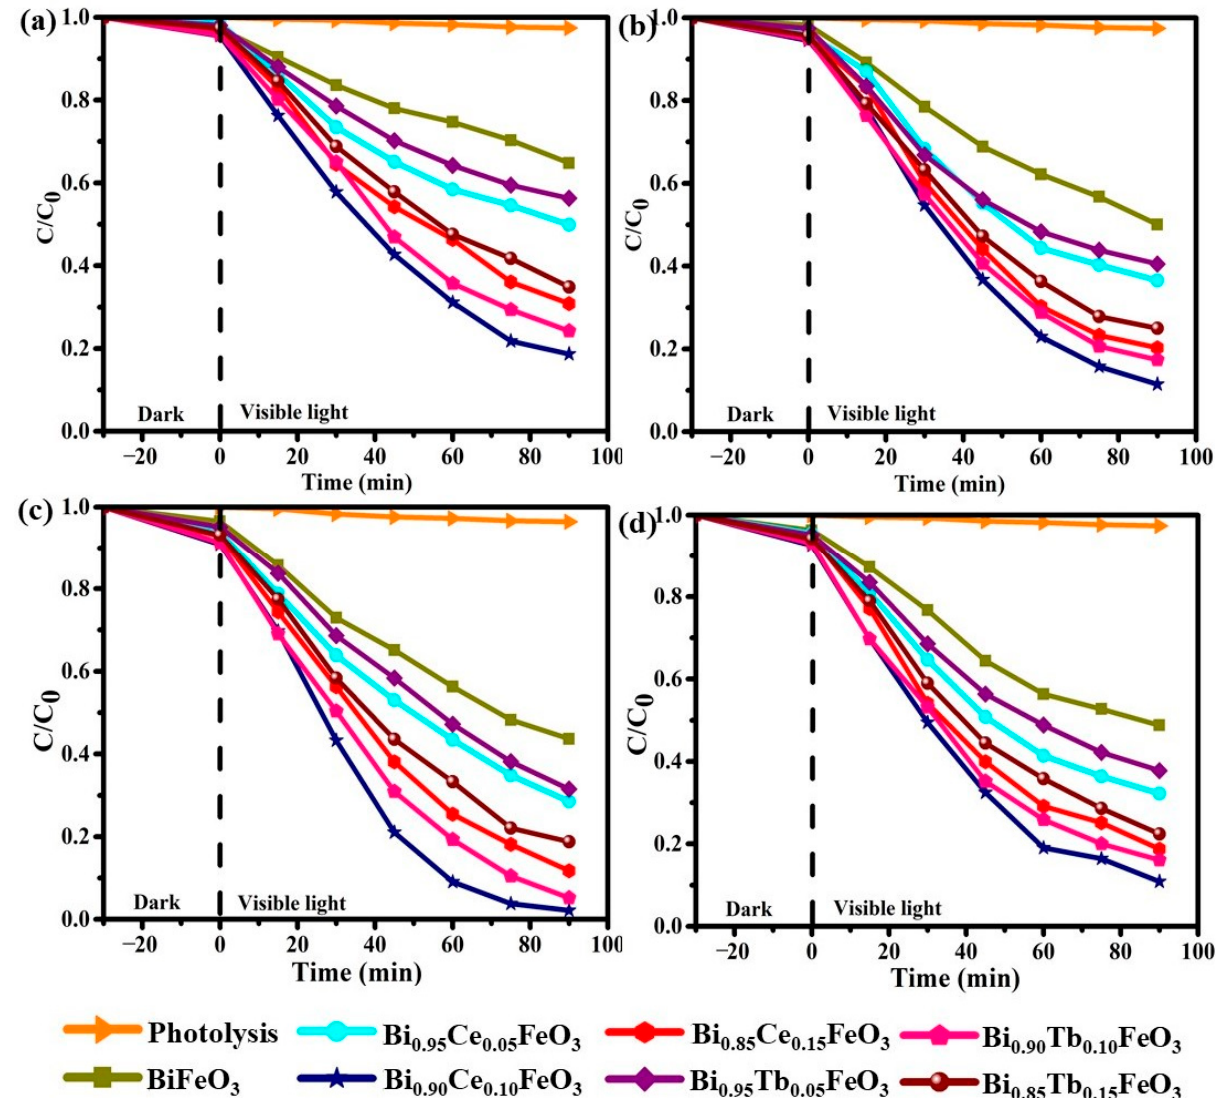
Figure 6. Photocatalytic degradation efficiencies of Bi 1 − x R x FeO 3 (R = Ce, Tb; x = 0.00, 0.05, 0.10 and 0.15) at ( a ) 0.0T ( b ) 0.3T ( c ) 0.5 T and ( d ) 0.7T of external MF.